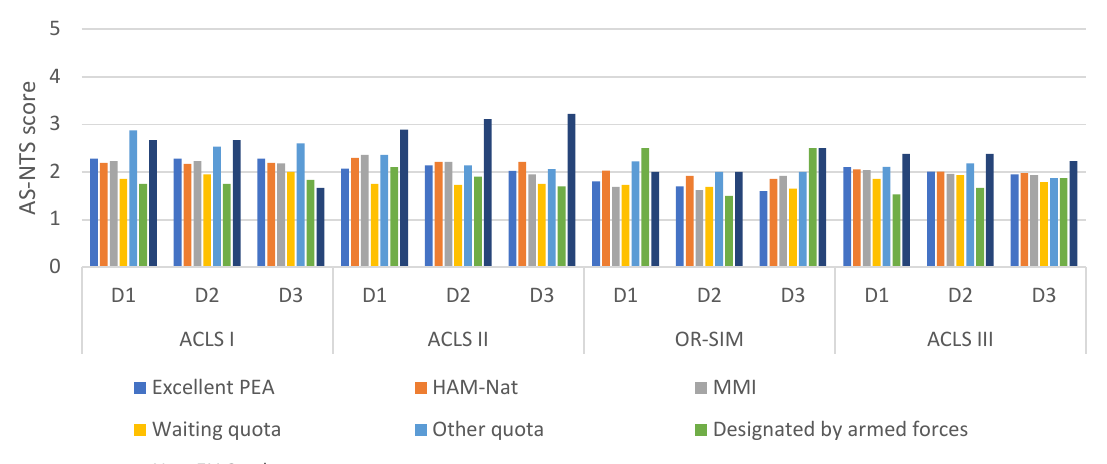
Figure 1. NTS performance of the investigated cohorts for each training session and each dimension of the AS-NTS. Abbreviations. MMIs = Multiple Mini Interviews; AS-NTS = Anaesthesiology students’ non-technical skills. ACLS = Advanced Cardiac Life Support. OR = Operating room. D = Dimension of AS-NTS. D1: Planning tasks, prioritising and problem-solving; D2: Teamwork and leadership; D3: Team orientation. Note: A low numeric AS-NTS score complies with a better NTS performance. To rule out the age of the participants as a confounding factor (on average, a.e. Table 3. NTS performance of the admission cohorts for each training session and each dimension of the AS-NTS.